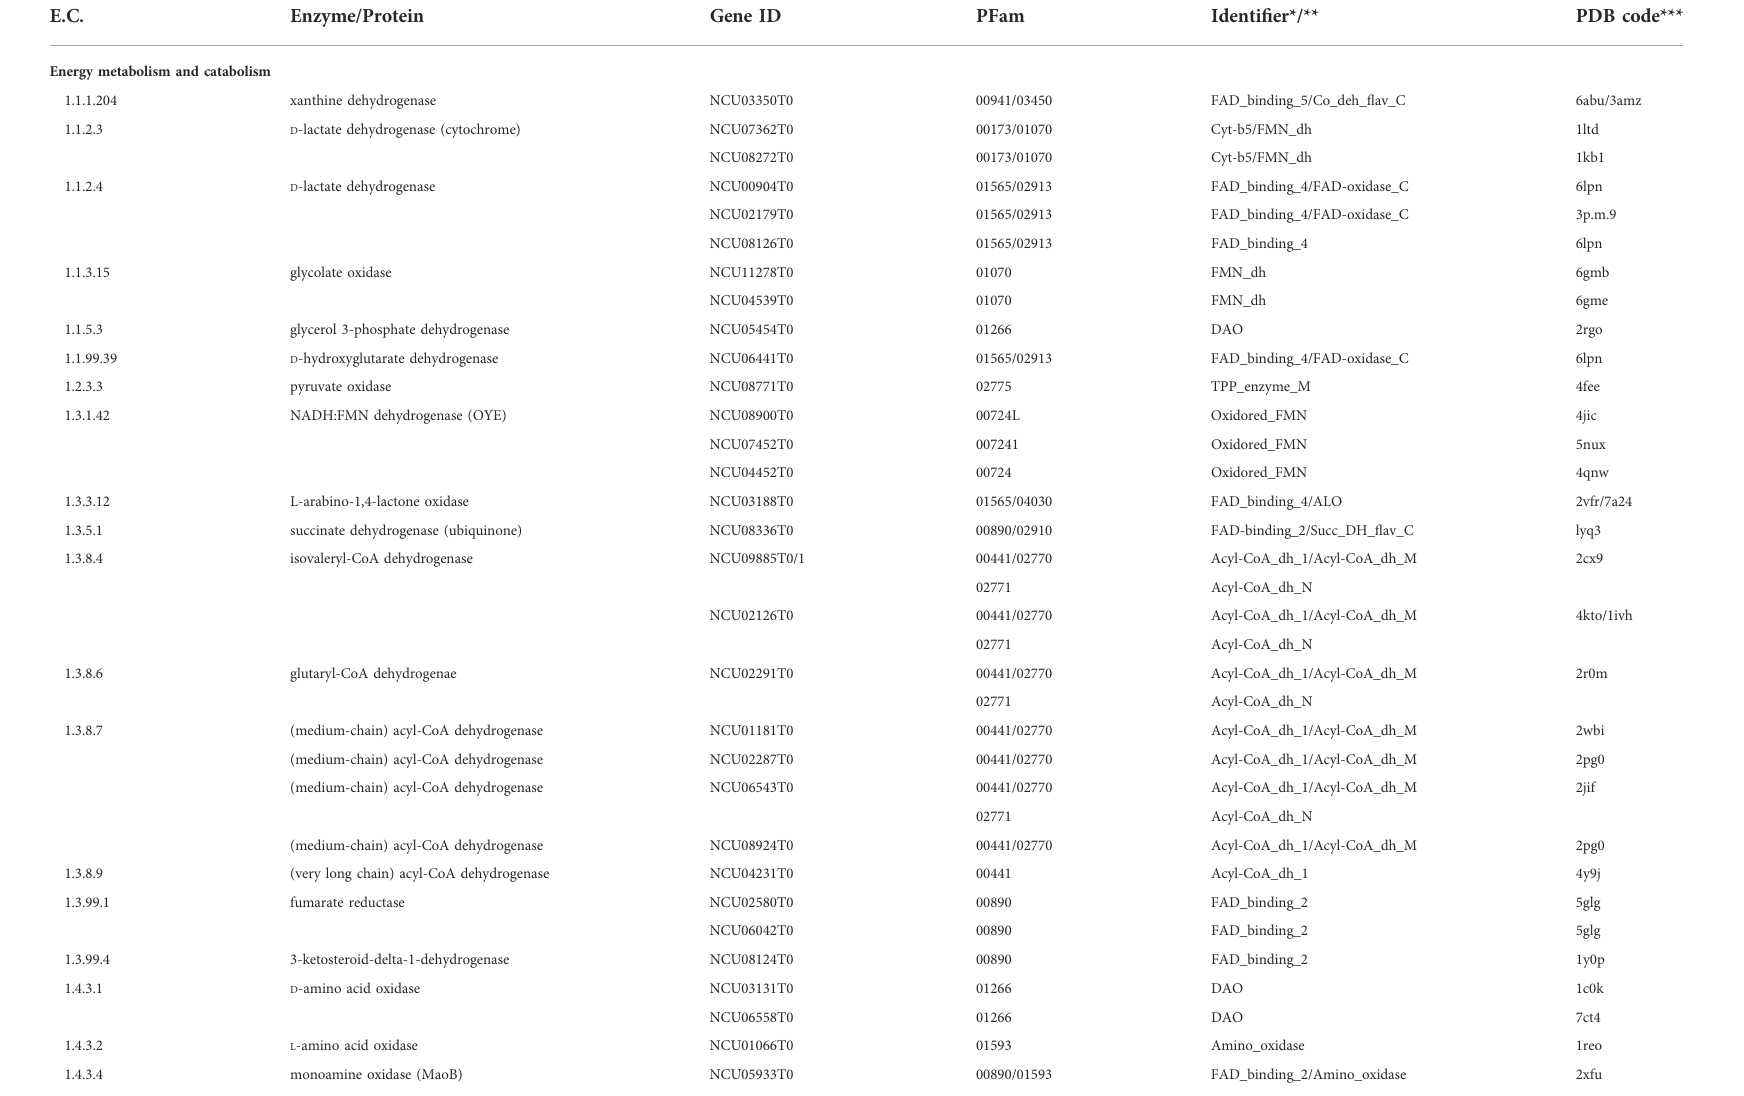
TABLE 1 The core fungal fl avoproteome of Neurospora crassa (tricarboxlic acid cycle, β -oxidation, amino acid metabolism, cofactor biosynthesis, carotenogenesis, metal uptake, tRNA-modi fi cations, light regulation, pyrimidine and purine